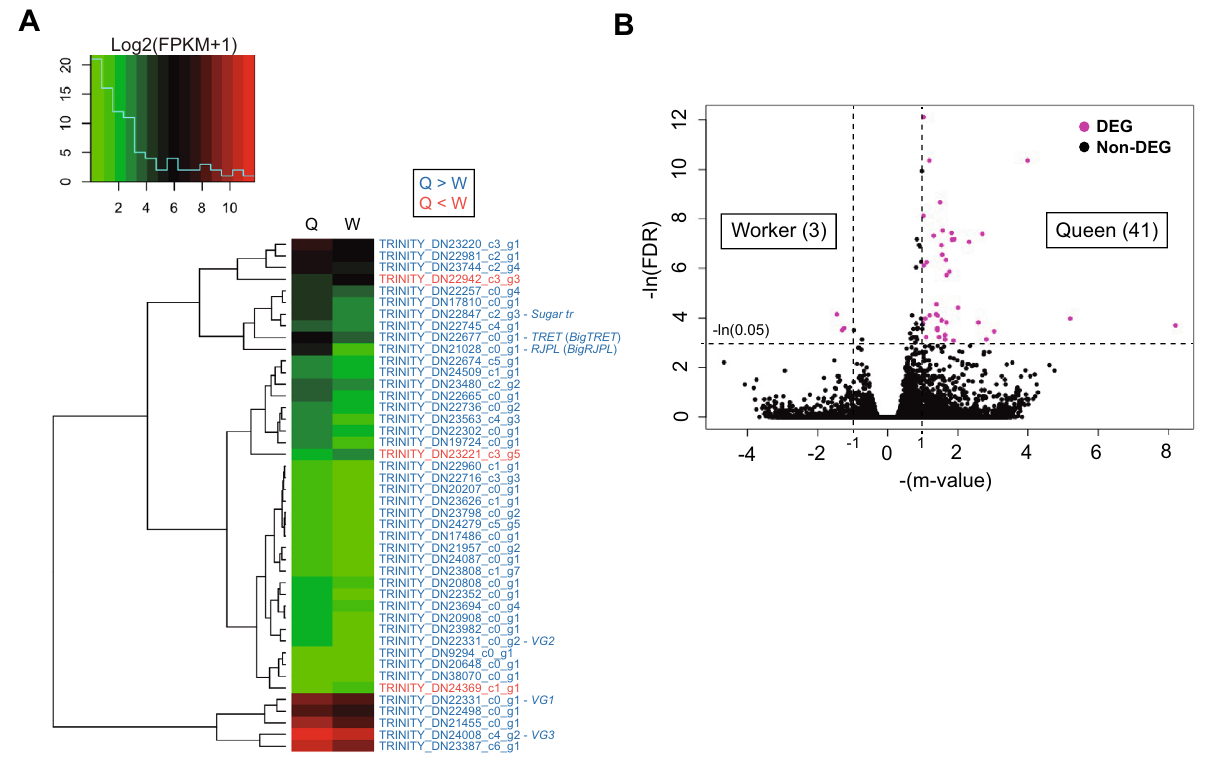
Figure 4. Differential gene expression between castes in Bombus ignitus was analyzed by RNA-seq. ( A ) a heat map of differential expression genes (DEGs) in queens (Q) and workers (W). The left panel above the graph indicates the frequency distribution of DEGs to log2(FPKM + 1). Expression levels increased from green to red. In the heat map, 41 DEGs were highly expressed in queens (blue text), whereas three DEGs were highly expressed in workers (red text). ( B ) a volcano plot of gene expression. Plots of DEGs and non-DEGs are indicated in magenta and black,